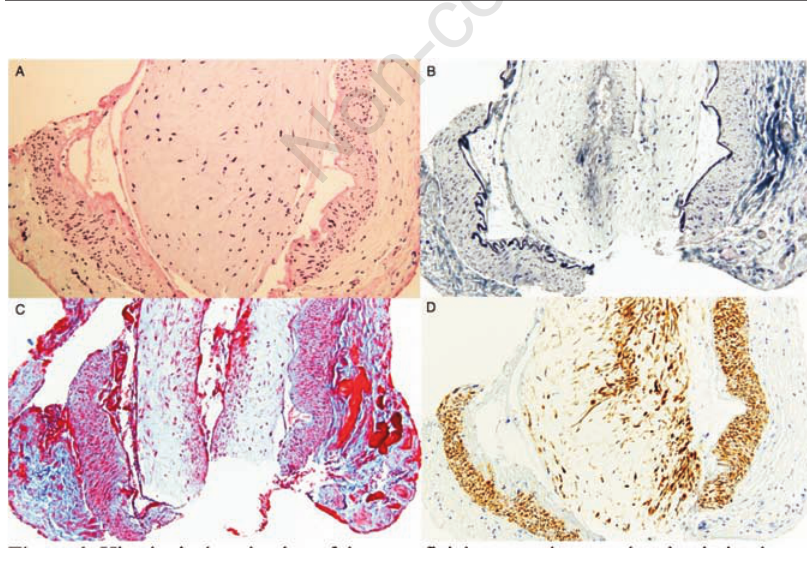
Figure 2. Histological evaluation of the superficial temporal artery showing intimal hyperplasia due to smooth muscle proliferation, scant collagen fibers, and myxoid change resulting in a narrowed lumen (H&E (A); Elastic stain (B); Trichrome stain (C); Smooth muscle actin stain (D)). Original magnification